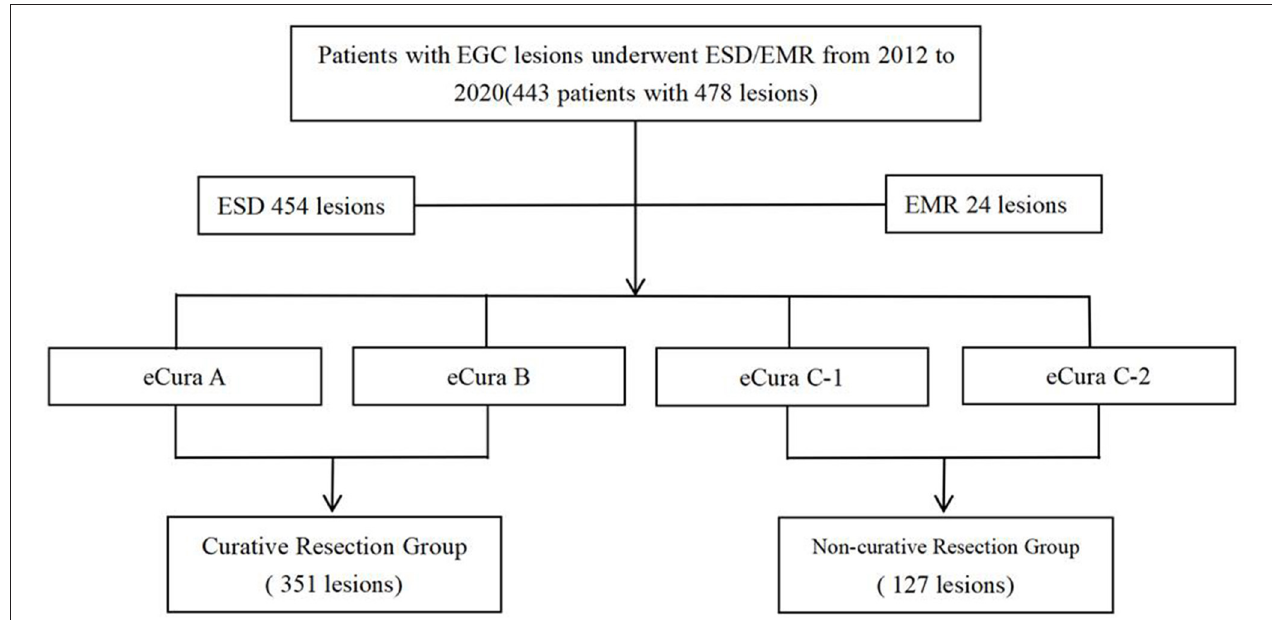
FIGURE 1 | Study design. A total of 443 patients, including the curative resection group and the non-curative resection group, were reviewed retrospectively.